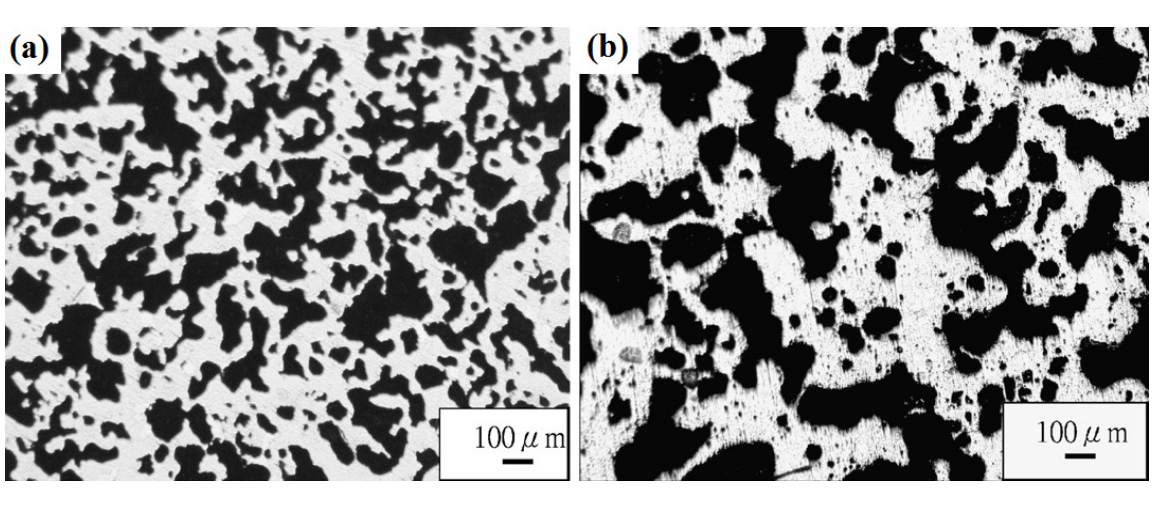
Figure 26. Optical microscopy (OM) micrographs of porous NiTi alloys with use of 0 ( a ) and 8.3 wt% ( b ) ammonium hydrogen carbonate [288]. Reprinted with permission from [288]. Copyright 2007